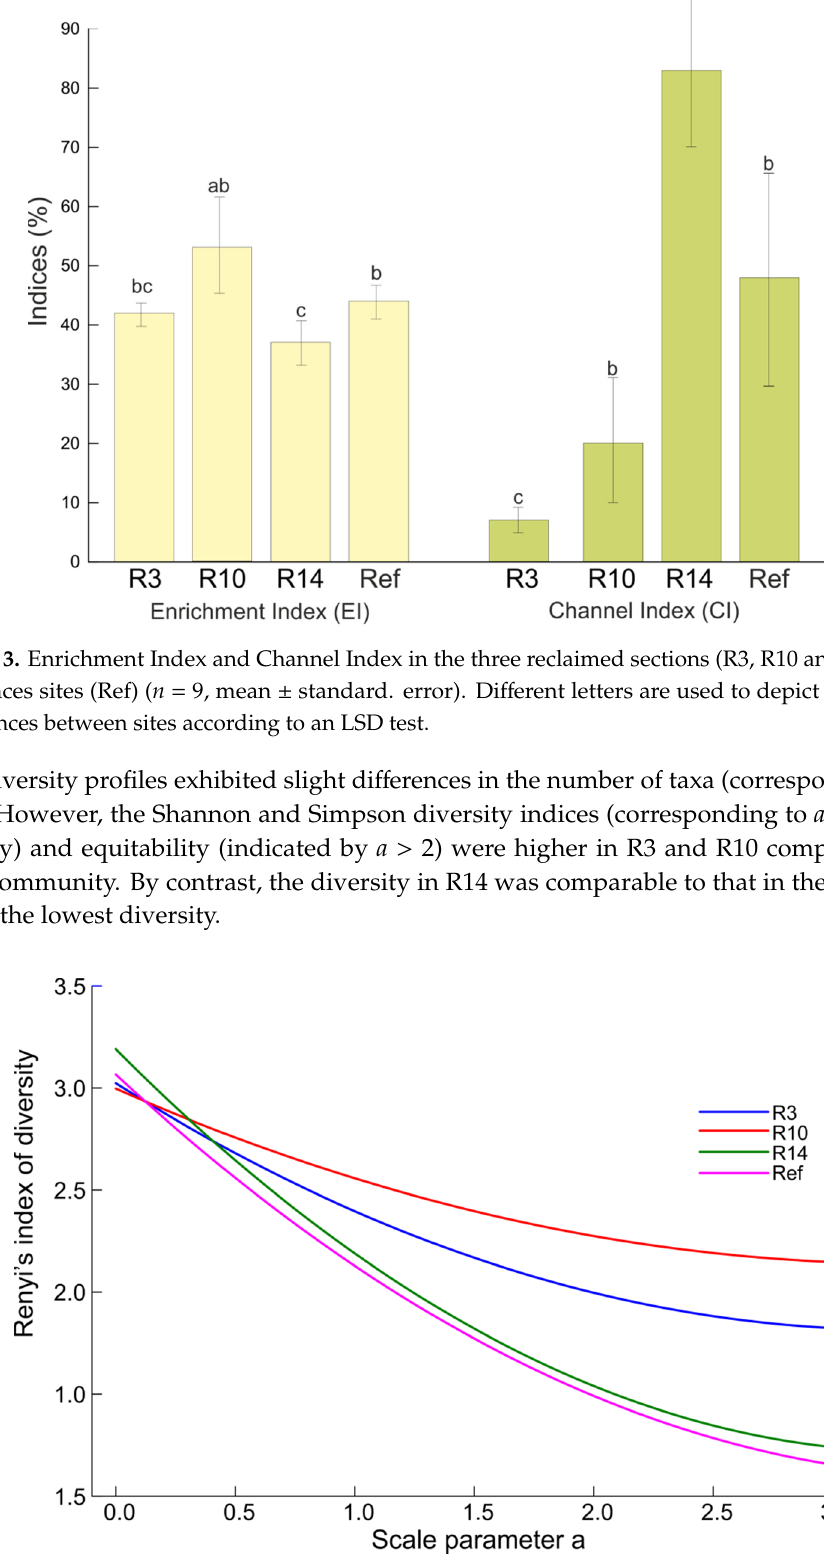
Table 3. Network parameters in the three reclaimed sections (R3, R10 and R14) and references sites (Ref). Stars show significant differences compared to corresponding average estimations made in 999 random networks with the same number of links. *** p < 0.001, ** p < 0.01, * p < 0.05. Network Variables